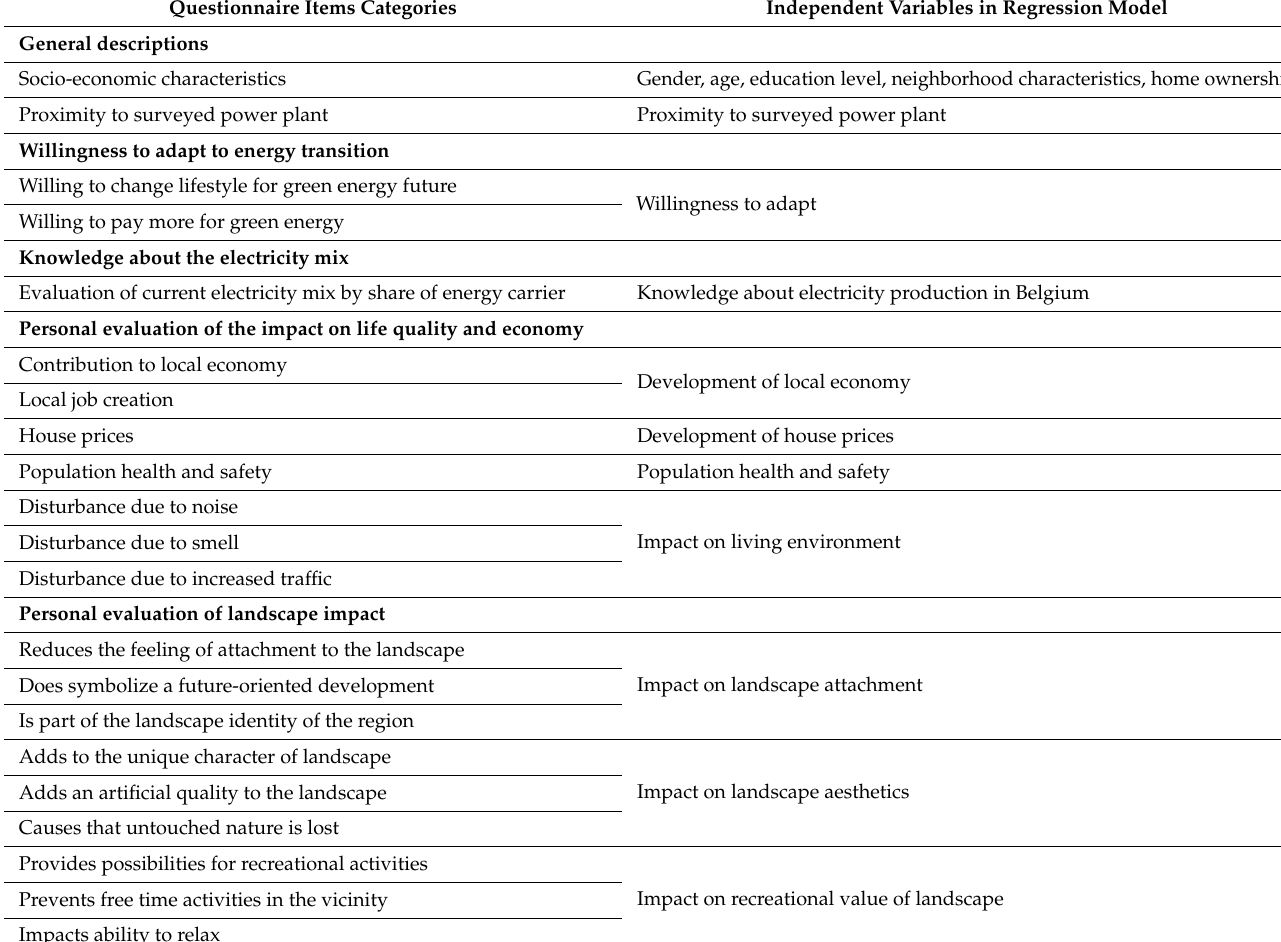
Table 2. Overview of questionnaire items and respective factor